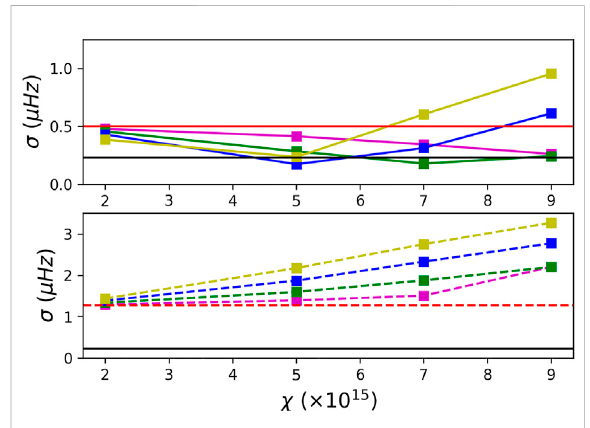
FIGURE 5 χ 2 test values (given by σ ( μ Hz )), of the theoretical large separation, when dark photons are introduced in the models, with respect to the RGB observations. The plot shows the variation of σ ( μ Hz ) vs. the dark photon kinetic mixing, χ . We consider dark photons and overshooting. The solid lines with squares represent the scenarios without overshooting, whereas the dashed with squares are the models combining dark photons and overshooting. The red solid line in the upper panel corresponds to models without dark photons nor overshooting, whereas the dashed red line in lower panel represents the overshooting models, without dark photons. The colors indicate dark photon masses of 300 eV (magenta), 500 eV (green), 700 eV (blue) and 900 eV (yellow). The observational 2 σ errors are indicated by the black solid line.